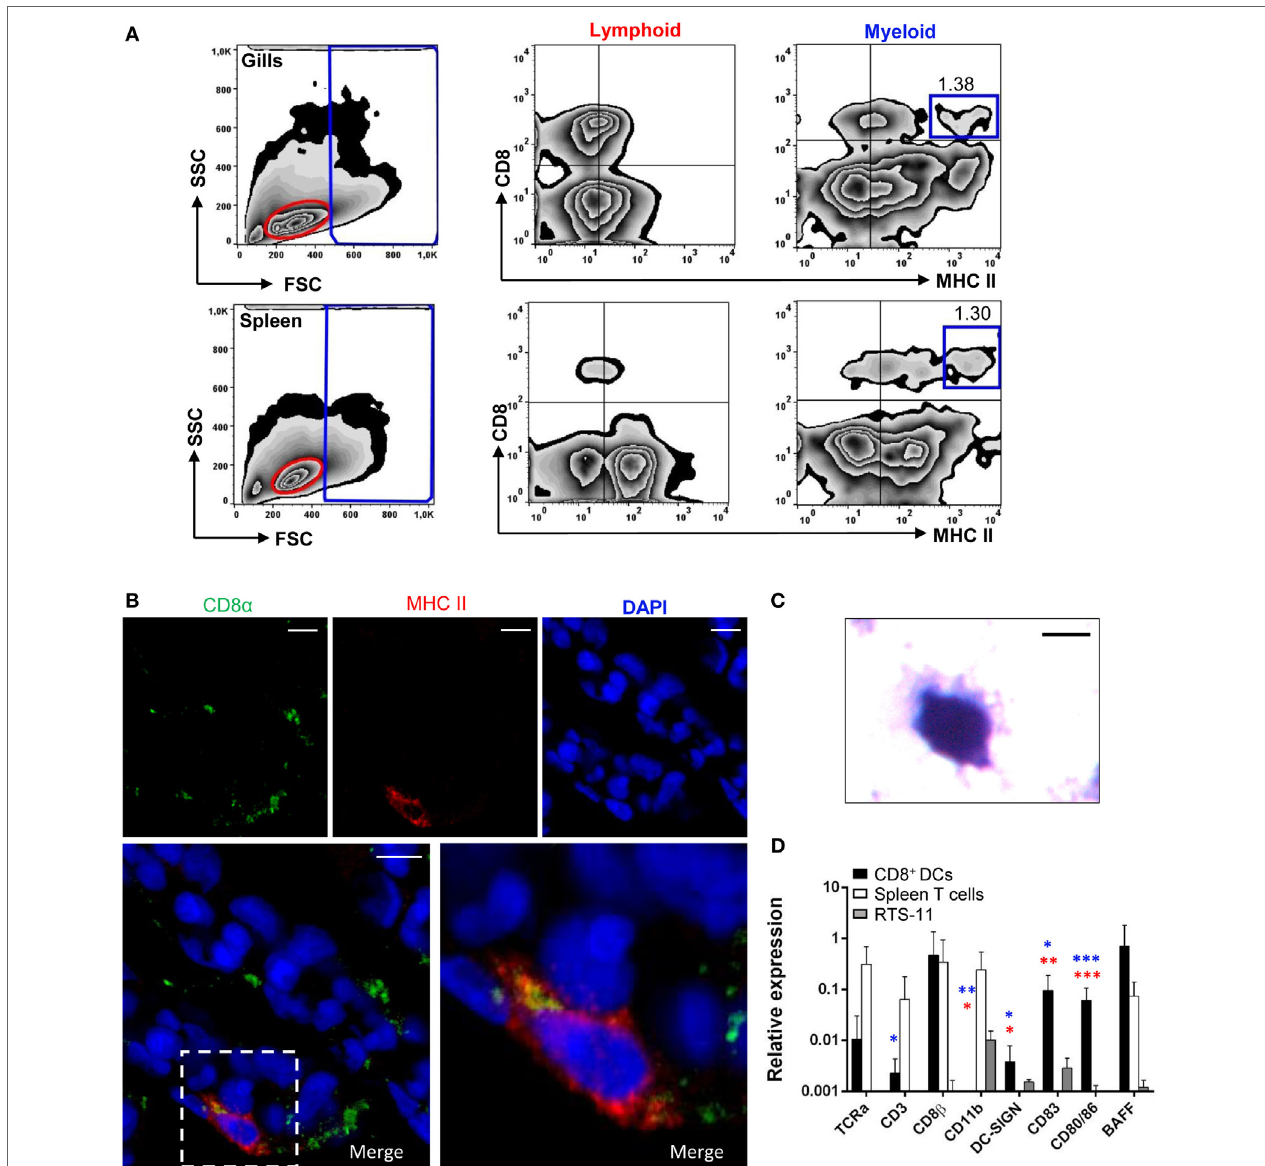
FigUre 1 | Identification and characterization of gill CD8 α + major histocompatibility complex (MHC) II + cells. (a) Flow cytometry analysis of rainbow trout leukocytes isolated from gills (top panels) and spleen (bottom panels) stained with anti-CD8 α and anti-MHC II mAbs. FSC/SSC profiles are shown (left) and gates for lymphoid (L) and myeloid (M) cells defined. Two-color CD8/MHC class II dot plots of lymphoid and myeloid gated cells are also shown. Percentage of myeloid CD8 + MHC II hi cells among the total number of cells in each gate is shown in the upper right corner. (B) Cryostat sections were prepared from rainbow trout gill, fixed and labeled with anti-CD8 α (green) and anti-MHC class II (red) Abs, counterstained with DAPI (blue), and analyzed by fluorescence microscopy. A representative image is shown, together with a magnification of a CD8 + dendritic cell (DC) (right). (c) CD8 α + MHC II + cells from gills were isolated by cell sorting and then incubated onto poly- l - lysine-treated glass slides, fixed, mounted, and analyzed by light microscopy (scale bar, 5 µm). (D) Gill CD8 + DCs and splenic CD8 + T cells were isolated by flow cytometry and RNA obtained. RNA was also obtained from the RTS11 monocyte–macrophage cell line. These RNAs were used to study the levels of transcription of different marker genes by real-time PCR. Relative expression of the indicated genes to the endogenous control elongation factor 1 α was calculated for each sample value. Mean values ( + SD) from three independent experiments are shown. Asterisks in red indicate significant differences between values obtained in gill CD8 + DCs and splenic CD8 + T cells, whereas asterisks in blue denote significant differences between values obtained in gill CD8 + DCs and RTS11 cells (* p ≤ 0.05, ** p ≤ 0.01, and *** p ≤